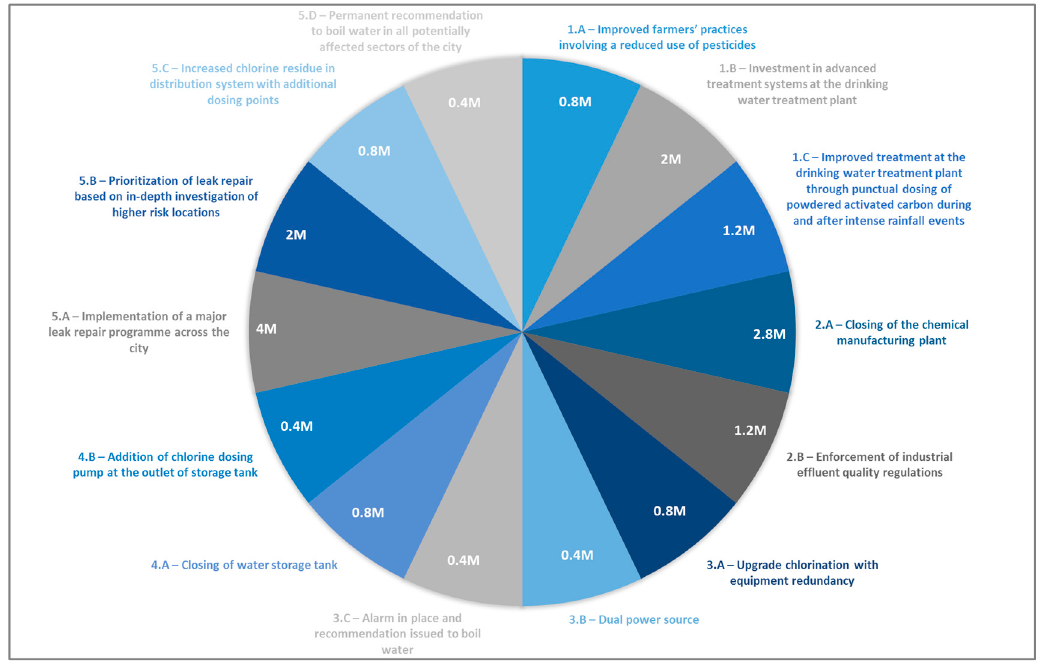
Figure 1. Chart used to illustrate investment decisions made by a team in round 2.